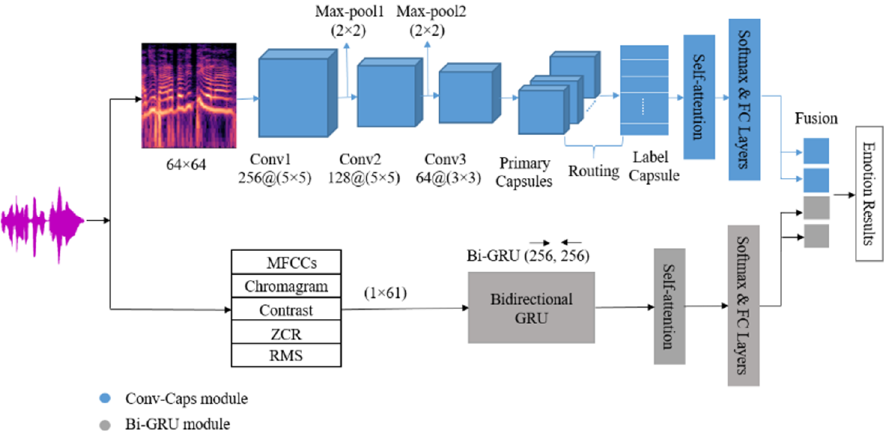
Figure 2. A visual representation of the proposed speech emotion recognition system using capsule and bi-directional GRU networks with a dual self-attention mechanism and a decision-level fusion technique for final classification.